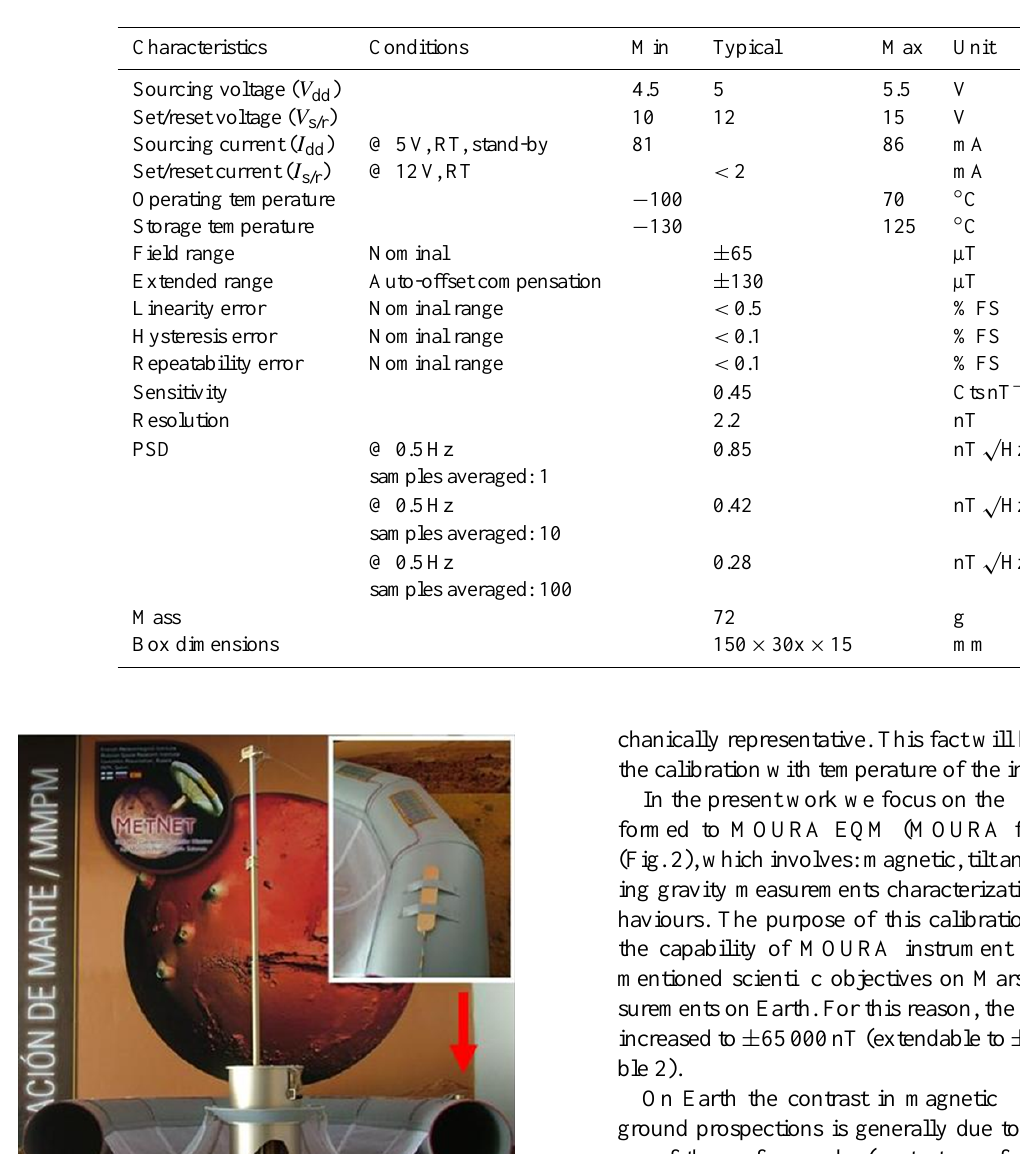
Table 2. MOURA characteristics summary.